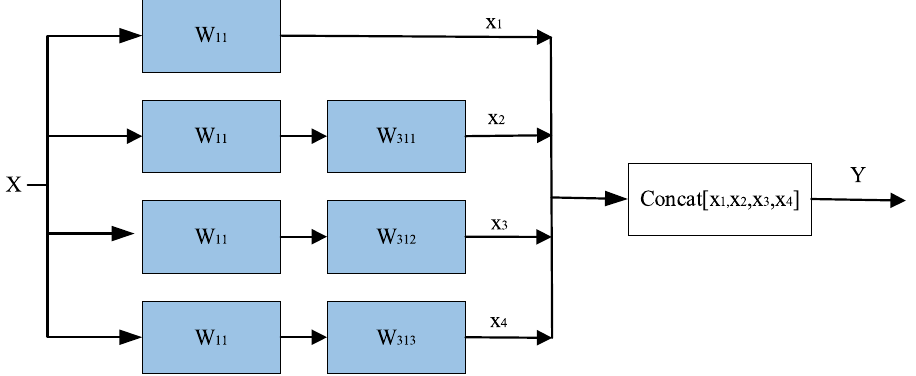
Figure 2. A detailed description of the AI module uses a 3 × 3 convolution kernel with dilated convolutions of 2, 4, and 8 to extract features, and the extracted features are merged with concat